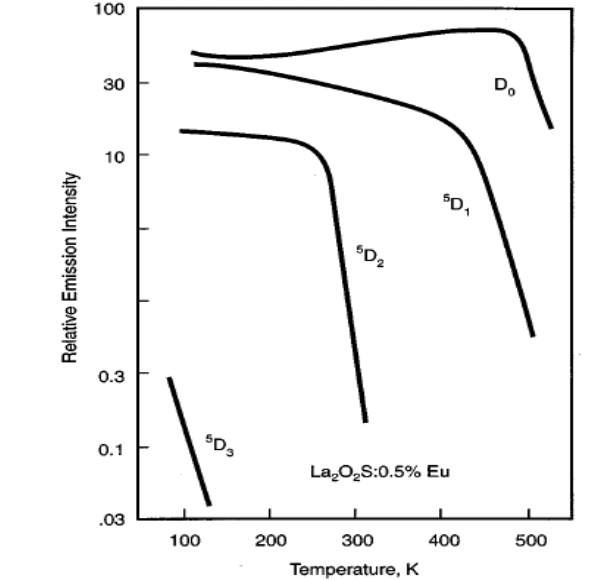
Figure 7. Variation of emission intensity with increasing temperature. Taken from